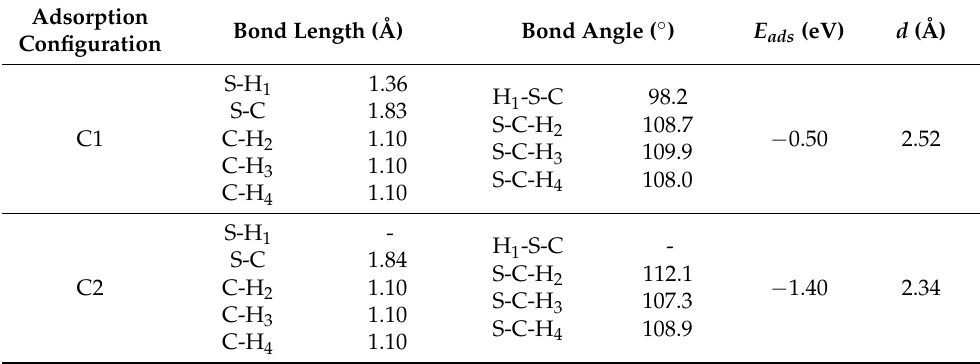
Figure 9. The stable adsorption configuration C1 of CH 3 SH molecules on the pure α -Fe 2 O 3 (001) surface; the stable adsorption configuration C2 of SH molecule on the vacancy α -Fe 2 O 3 (001) surface (the unit of number is Å). Table 4. The adsorption energy and adsorption configuration characteristic parameters of CH 3 SH on the α -Fe 2 O 3 surface. Adsorption Configuration